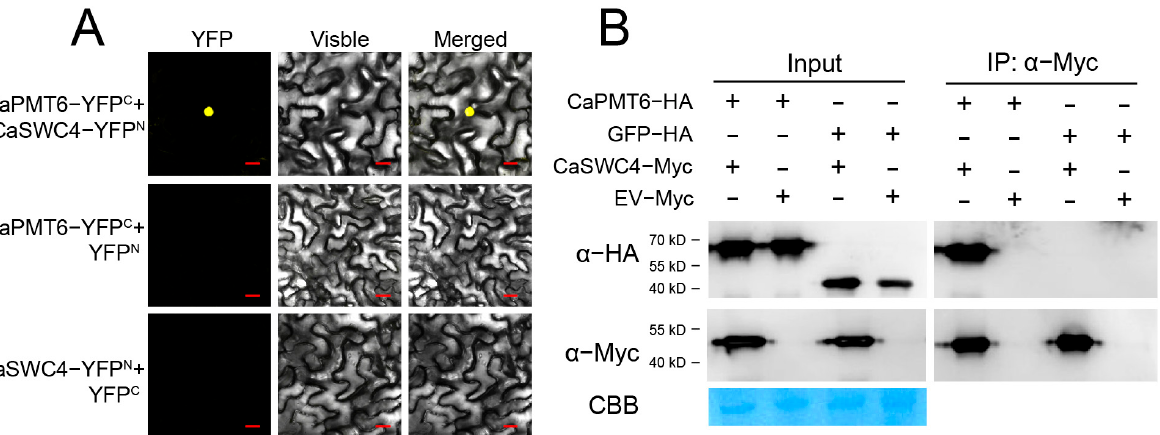
Figure 2. The interaction between CaPMT6 and CaSWC4. ( A ) CaPMT6 interacts with CaSWC4 by BiFC, CaPMT6 was fused to YFP C , and CaSWC4 to YFP N , which were co-transiently overexpressed in leaves of NB plants by agroinfiltration, and the YFP signal was detected under a laser scanning confocal microscopy at 48 hpi, Yellow fluorescence, visible light, and merged images were taken on a confocal microscope at 48 hpi. Bars = 25 µ m. ( B ) Interaction between CaPMT6 and CaSWC4 in vivo, as determined by co-immunoprecipitation assay; proteins were isolated from pepper leaves transiently overexpressing CaPMT6-HA/CaSWC4-Myc, which were immunoprecipitated with anti- Myc antibody; and the presence of the tested interacting proteins was detected using antibody of HA by western blotting.